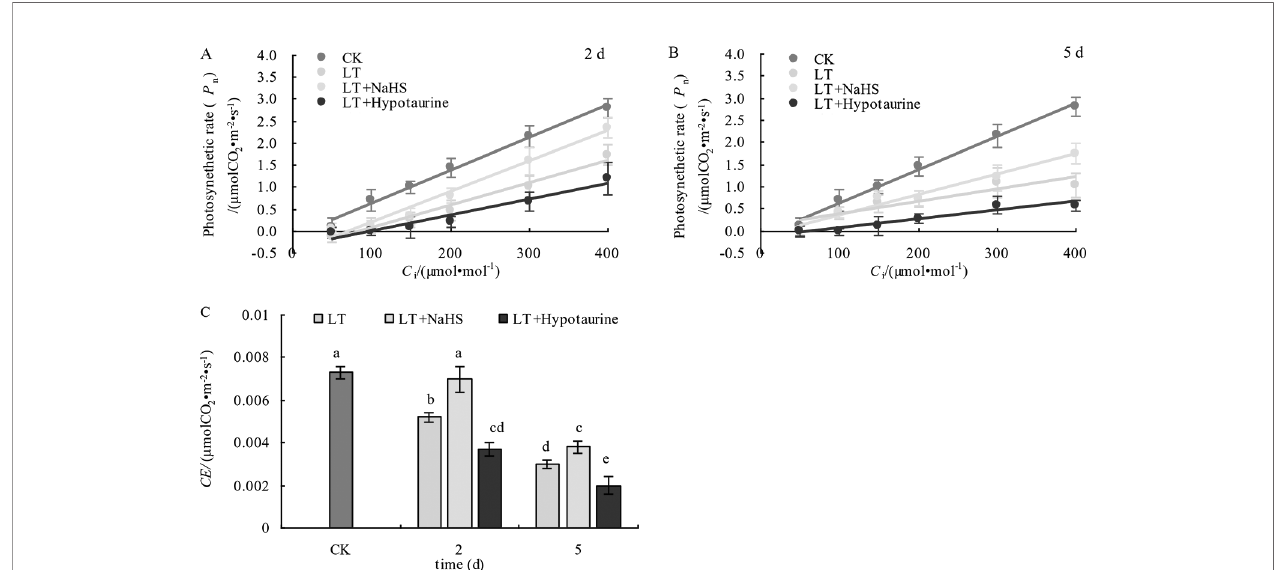
FIGURE 9 | Effects of exogenous NaHS and HT on the initial slope (A , B) and CE (C) of the CO 2 response curve of blueberry leaves under low temperature stress. The data in the fi gure are from fi ve replicated experiments (n=5), and represent means ± standard error (SE). Different small letters show signi fi cant differences ( P < 0.05).CK: room temperature control at 25°C; LT: low temperature treatment; LT + NaHS: low temperature treatment at 4 – 6°C after spraying 0.5 mmol·L – 1 NaHS; LT + Hypotaurine: low temperature treatment at 4 – 6°C after spraying leaves with 200 m mol·L – 1 hypotaurine.